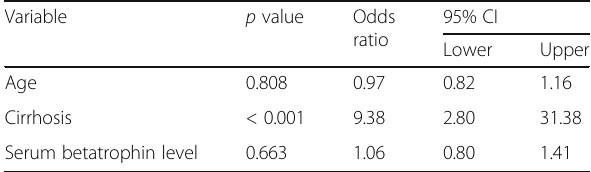
Table 2 Determinants of insulin